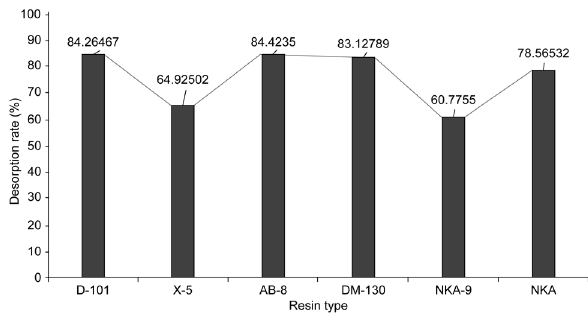
Figure 1: Graph showing the desorption rates of different resins.